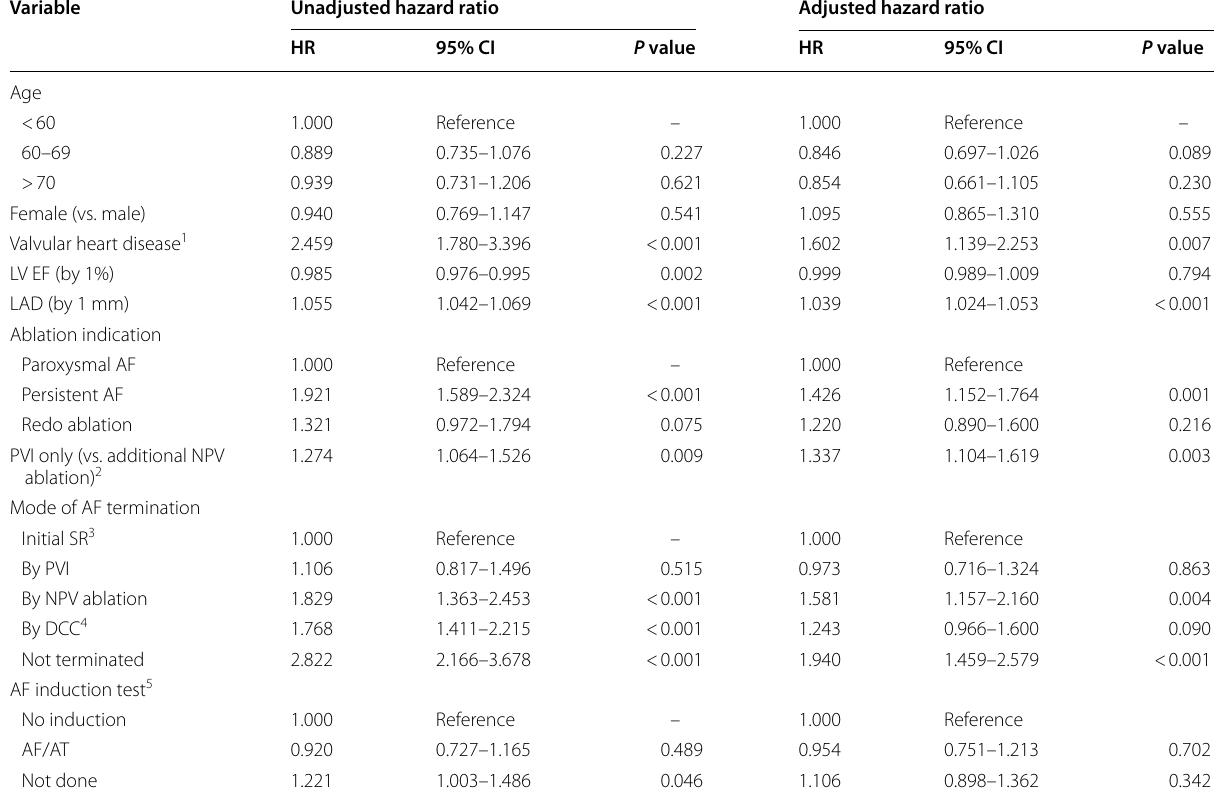
Table 5 Cox proportional hazard model for rhythm outcome (recurrence at 1